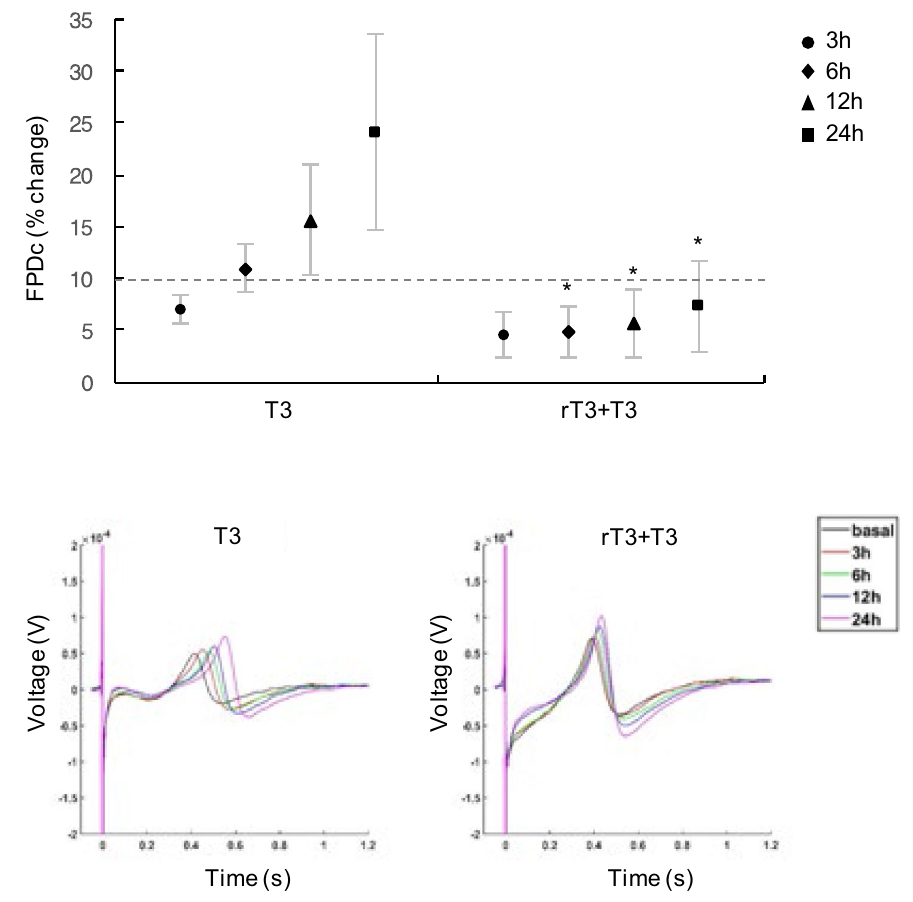
Figure 5. Reverse T3 blocks the T3-dependent FPDc prolongation. Analysis of FPDc T3-treated cells after the preincubation with 1 nM rT3 or rT3 vehicle (ammonia solution) at the indicated times. Data are expressed as the percentage change of FPDc compared to baseline values; lower panel: representative extracted FPD waveforms of hiPSC-CMs treated as previously described. *p <